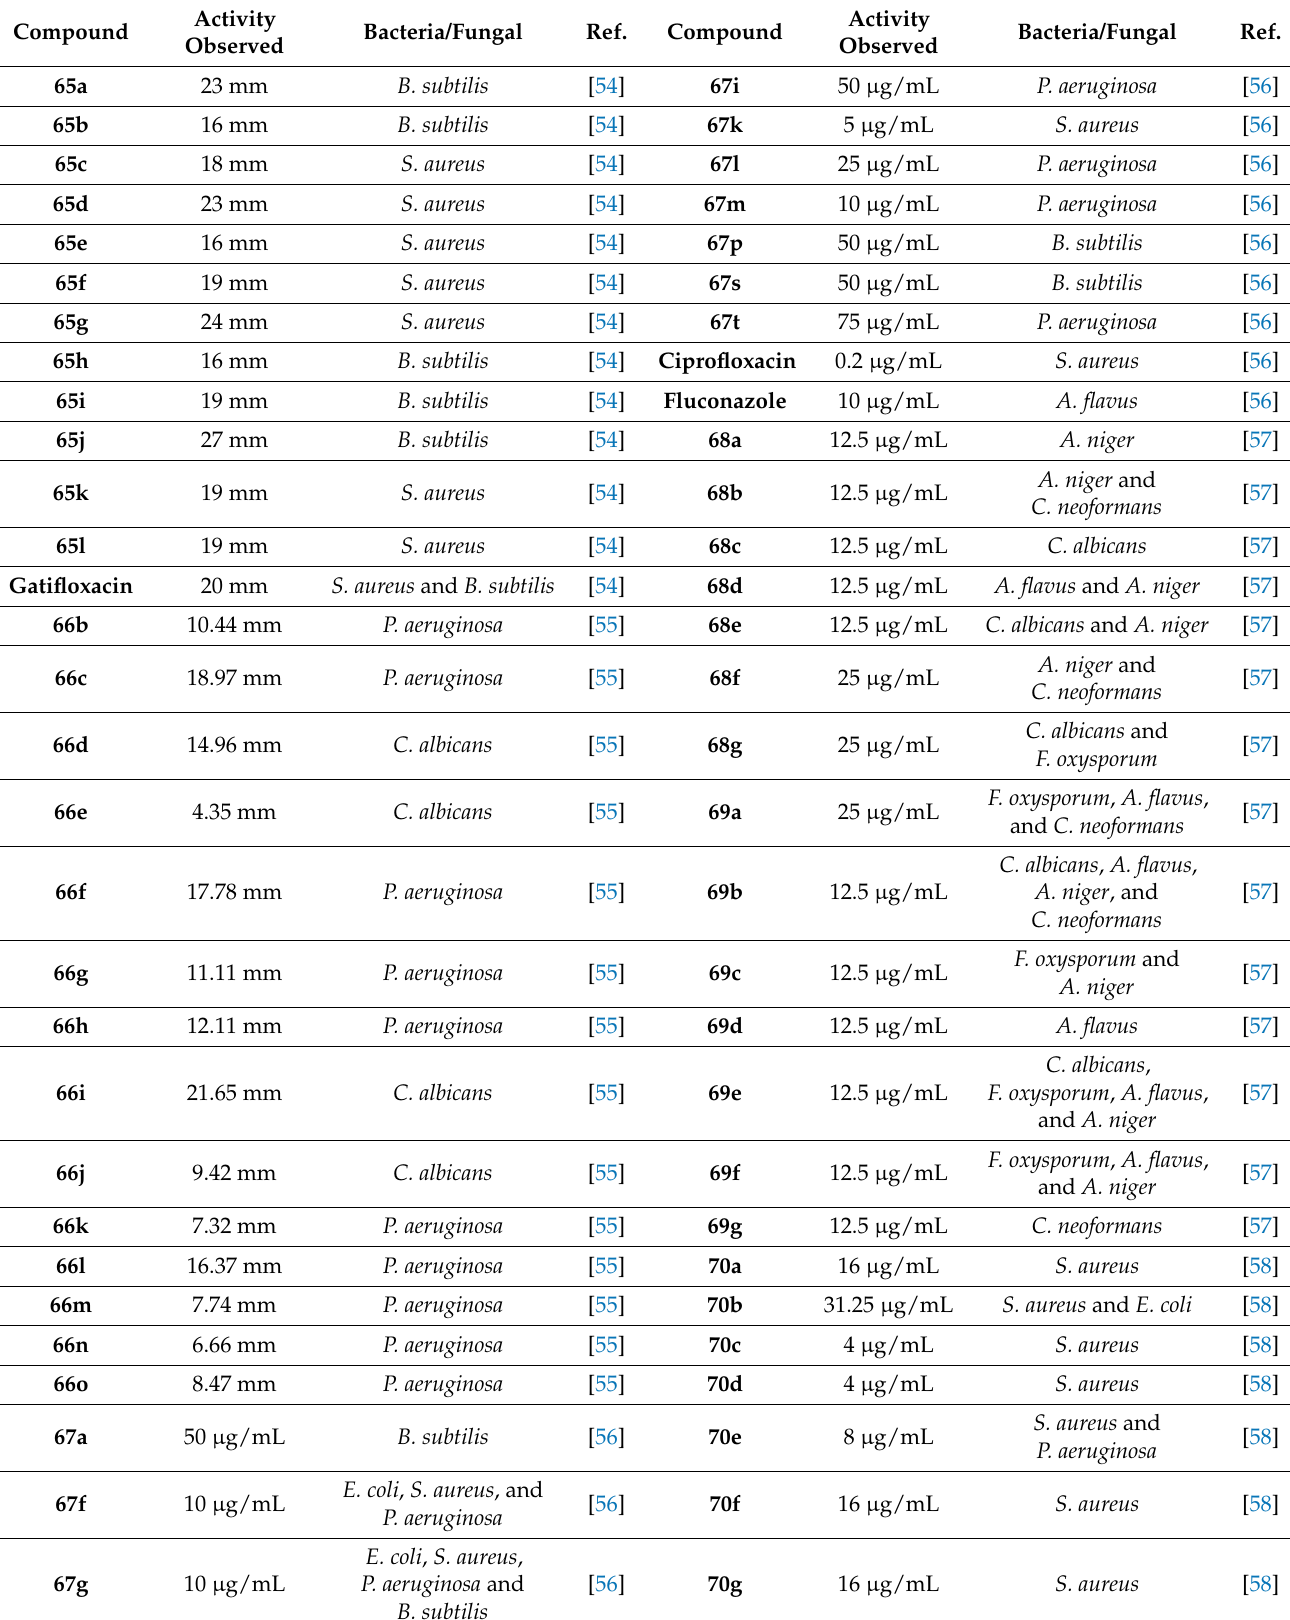
Table 5. Antimicrobial activity data of reported coumarin triazole